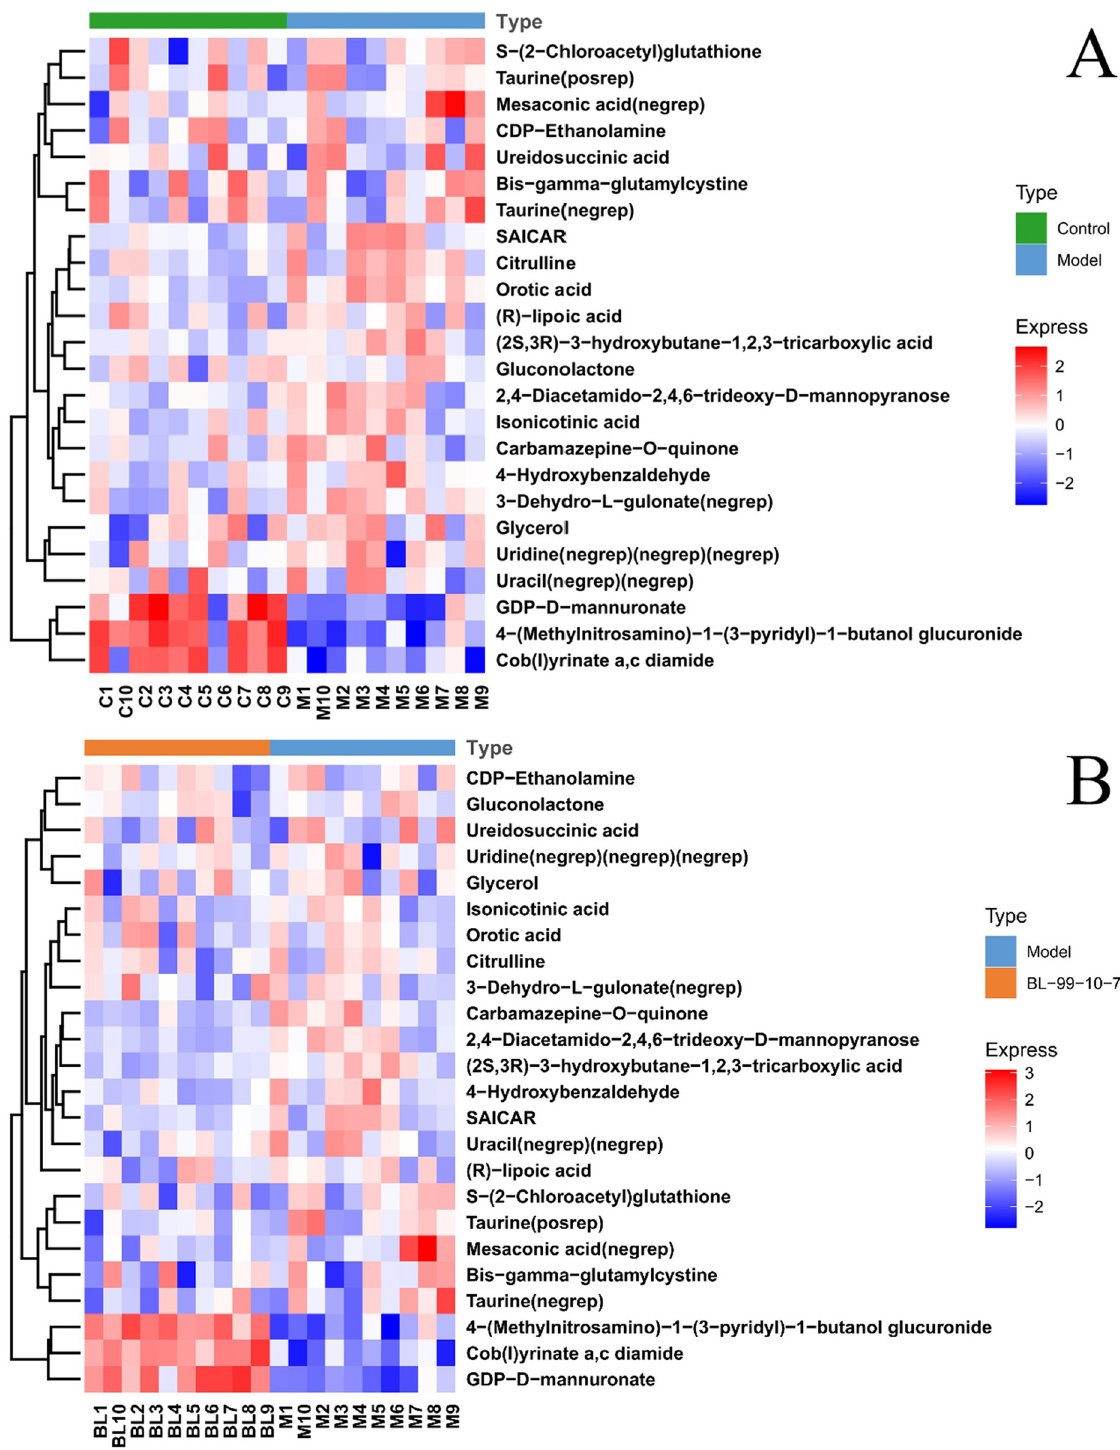
Fig 6. Heat map of significantly changed metabolites. Statistically markedly changed metabolites between the intestinal functional disorder adult zebrafish (model) and normal control (untreated) zebrafish (A); and between the model zebrafish treated with and without B . lactis BL- 99